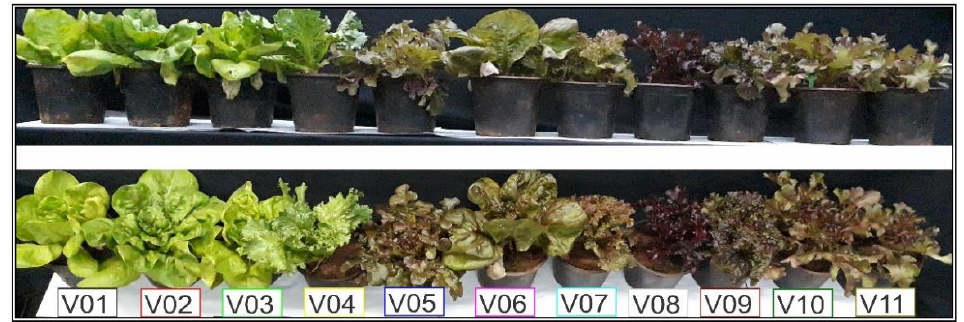
Figure 1. Images of lettuce ( Lactuca sativa L.) plants evaluated in this study, displaying significant bioaccumulation of pigment variations (accumulation of the pigments based secondary metabolism). Upper panel, details of the lateral profile. Lower, detail of the plant leaves. The box displays eleven different genotypes of lettuce: V01 — Rainha de Maio, V02 — Vitória, V03 — Maravilha de Inverno,